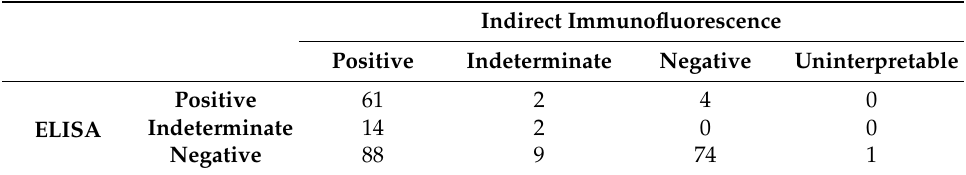
Table 1. Results of ELISA compared with indirect immunofluorescence (IIF).